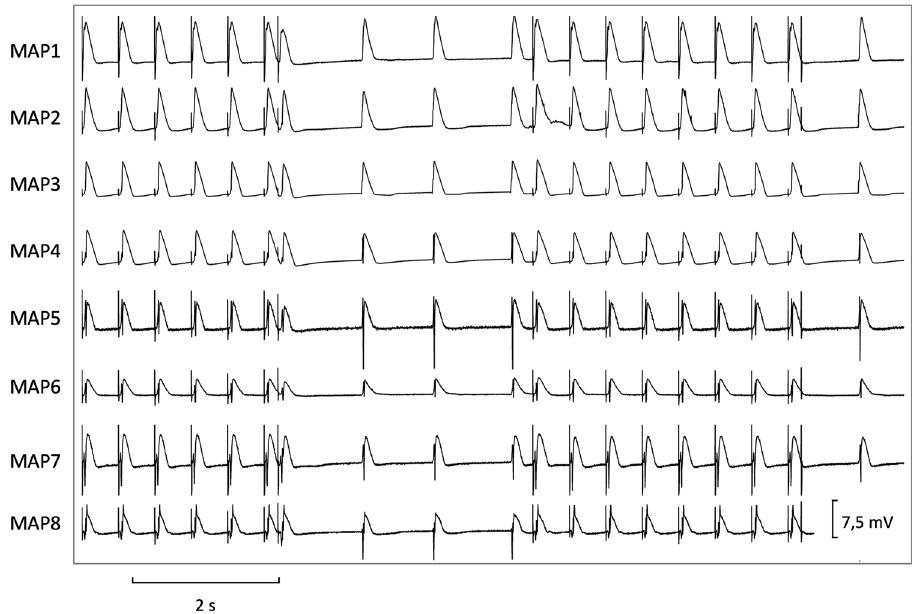
Figure 1. Determination of effective refractory periods at a basic cycle length of 500 ms (MAP = monophasic action